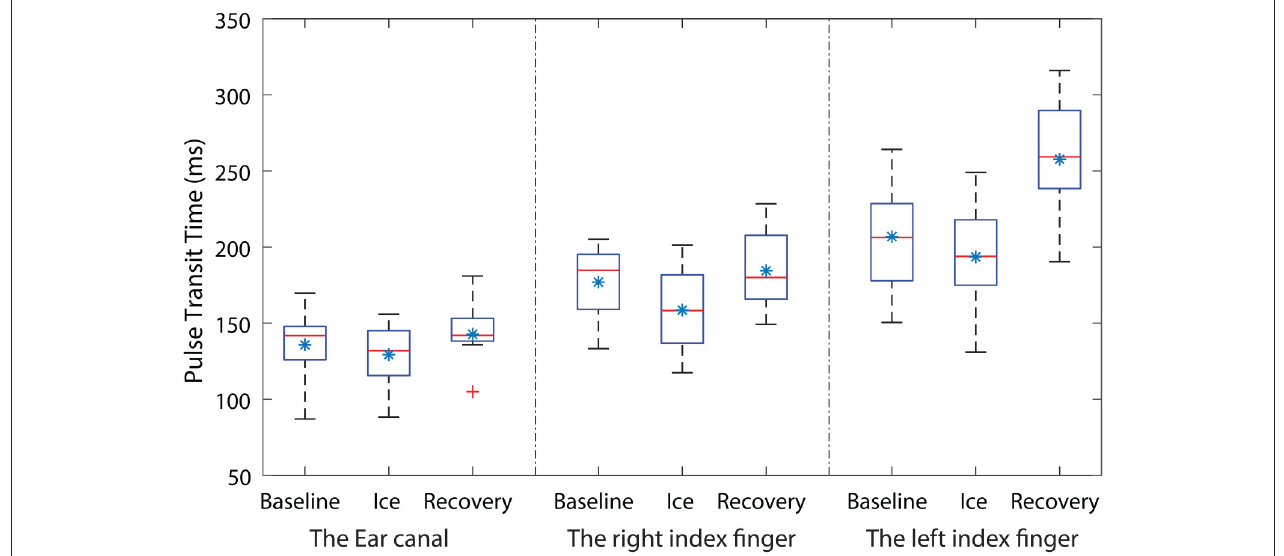
FIGURE 2 | Box-plots showing the changes in PTT measured during all three stages of the experiment from the ear canal (EC), the right index finger (RIF) and the left index finger (LIF). Each box represents the interquartile range of the mean PTT measured from 12 volunteers. The red line in each box shows the median value of the data, the ∗ shows the mean and + shows the outliers.